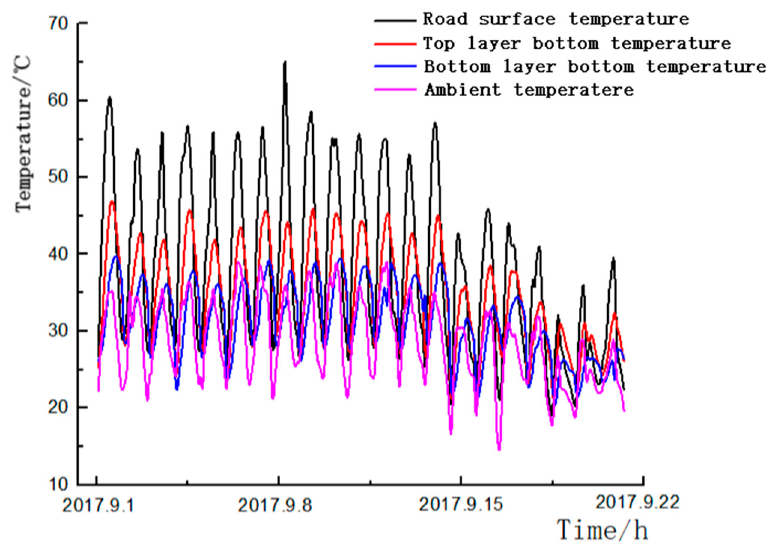
Figure 5. Measured ambient and pavement temperature data.